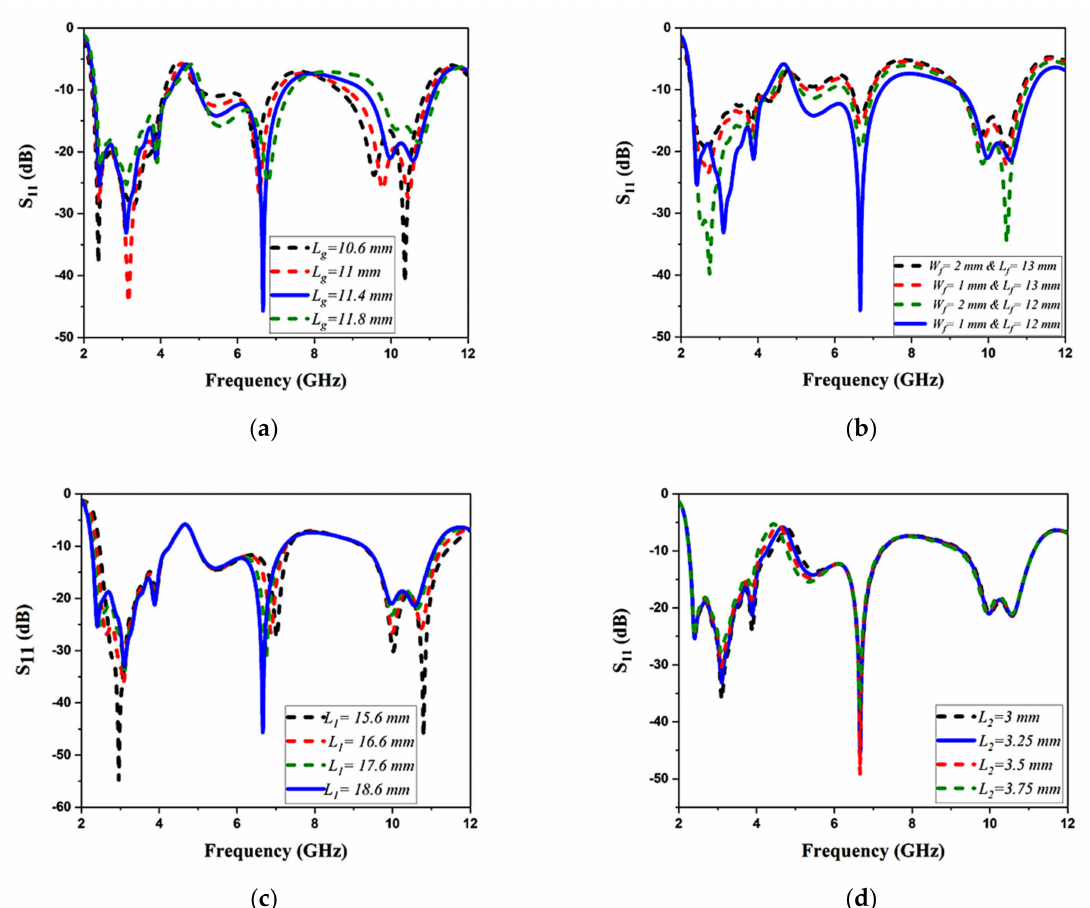
Figure 7. The effect on the reflection coefficient S 11 of ( a ) L g ; ( b ) W f and L f ; ( c ) L 1 ; ( d ) L 2